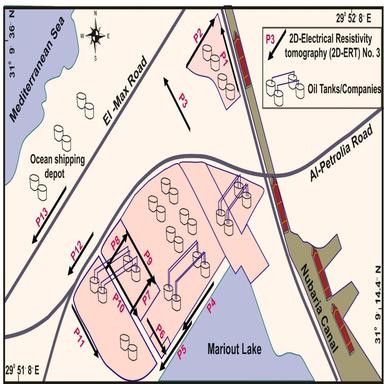
Location map showing the measured 2D-ERI profiles (black lines) locations over the entire study site.